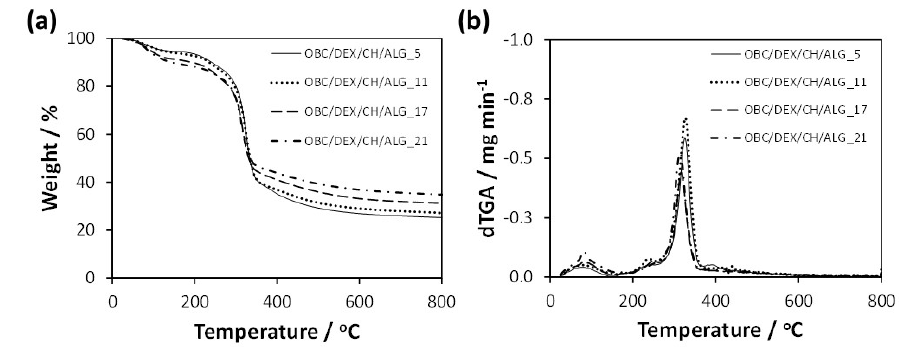
Figure3. ( a )Thermogramsand( b )derivativecurvesofthemulti-layeredpatches: OBC / DEX / CH / ALG_5, Figure 3. ( a ) Thermograms and ( b ) derivative curves of the multi-layered patches: OBC / DEX / CH / ALG_11, OBC / DEX / CH / ALG_17, and OBC / DEX / CH / ALG_21. OBC/DEX/CH/ALG_5, OBC/DEX/CH/ALG_11, OBC/DEX/CH/ALG_17, and OBC/DEX/CH/ALG_21.